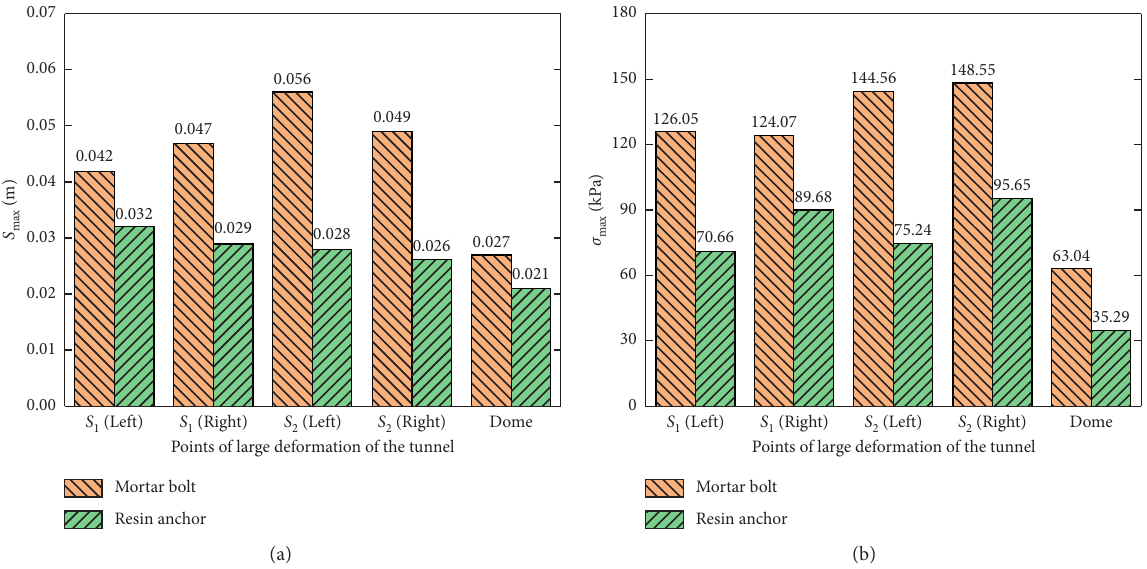
Figure 11: The length of mortar bolt support and bolt support is 7.5m: (a) S